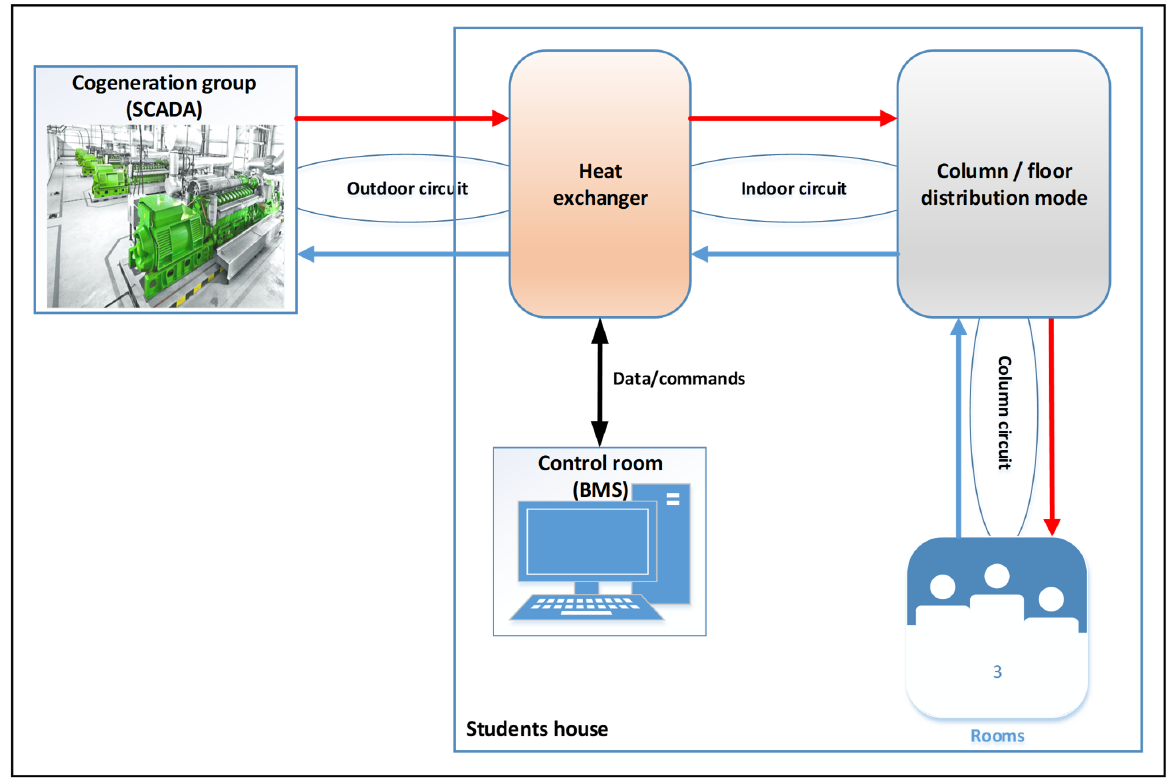
Figure 3. Circuit diagram of the existing thermal agent in the system.